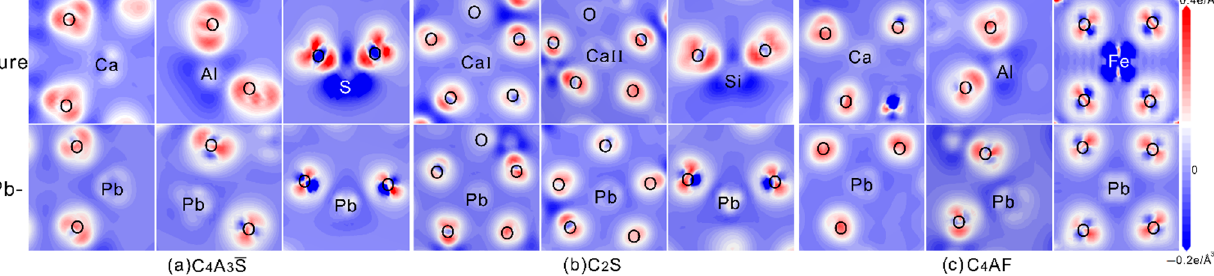
Figure 6. Electron density difference (EDD) of pristine and Pb-doped minerals of SAC clinker: ( a ) C 4 A 3 S(cid:3364) , ( b ) C 2 S and ( c ) C 4 AF. The blue and red isosurfaces stand for electron accumulation and reduction, respectively.